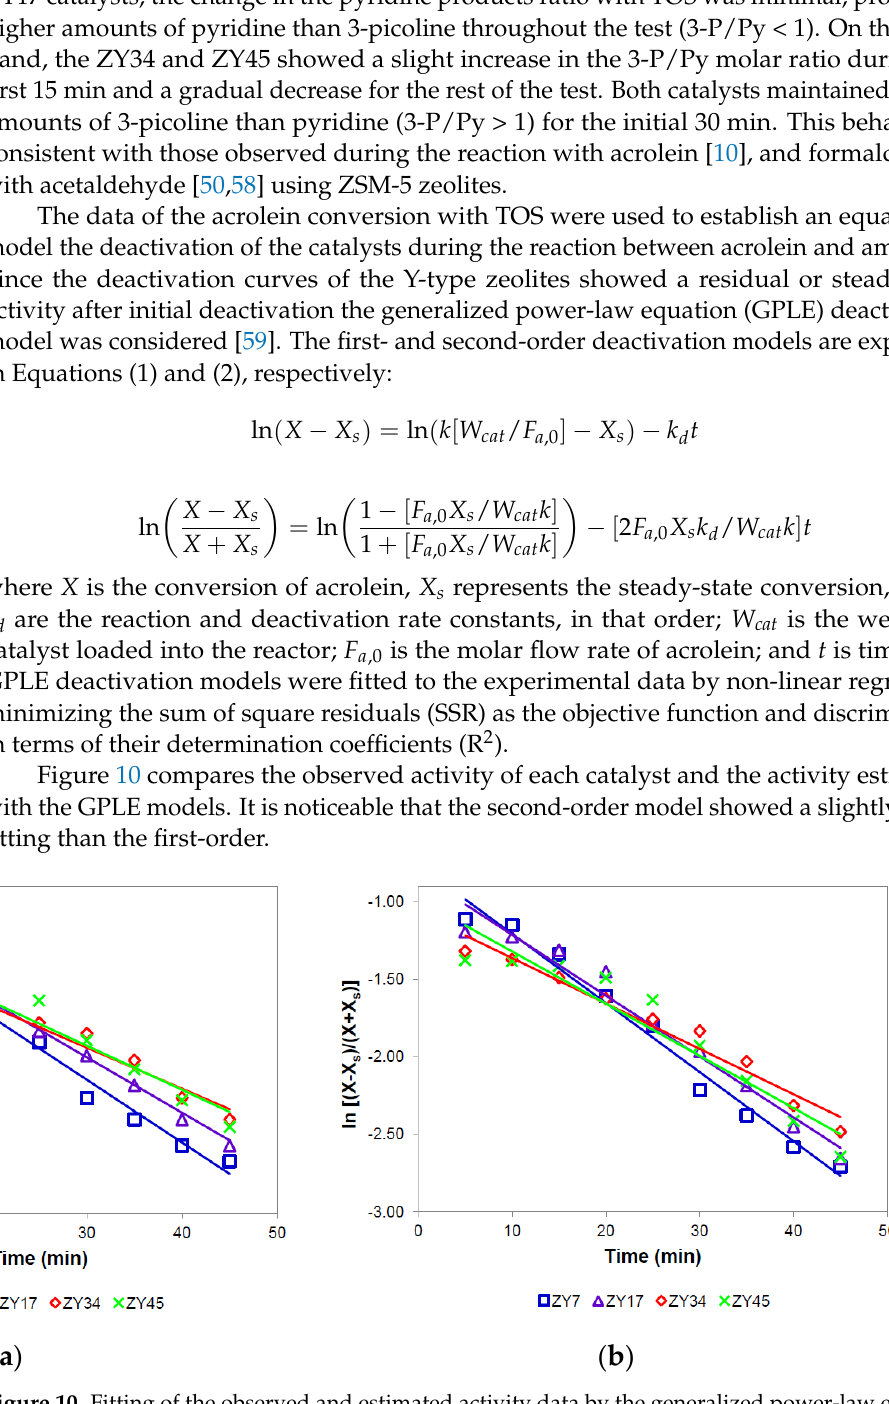
Figure 10. Fitting of the observed and estimated activity data by the generalized power-law equation (GPLE) models: ( a ) first-order model and ( b ) second-order model.